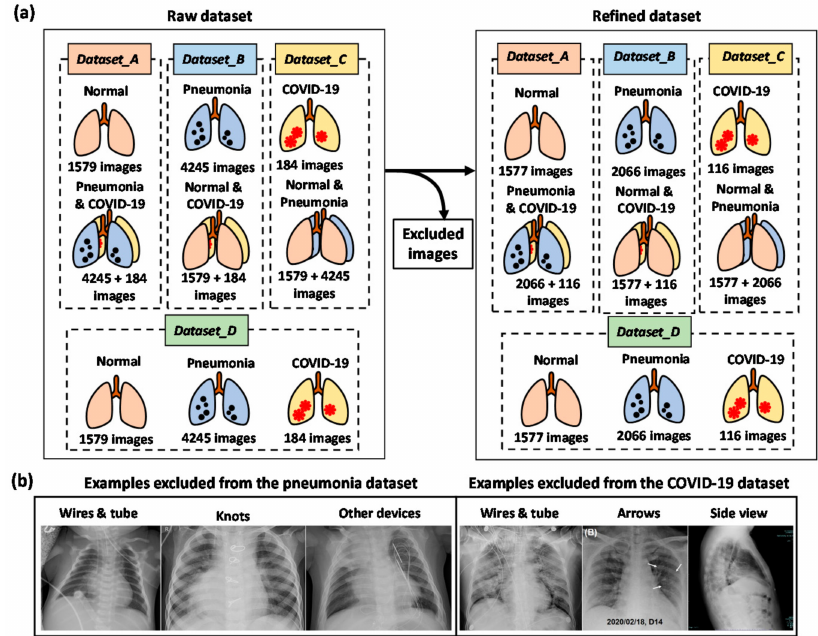
Figure 1. Dataset preparation. ( a ) The raw and refined datasets used in this study. ( b ) Represented images excluded from the pneumonia (left) and COVID-19 (right)